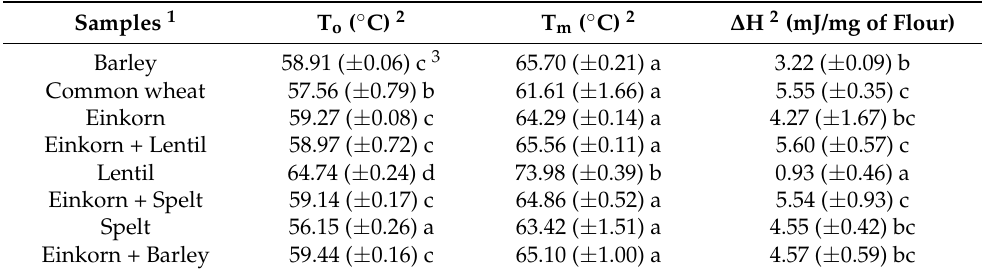
Table 2. Starch gelatinization parameters of slurries (35% w / w ) of the flour samples used for breadmaking; heating rate 5 ◦